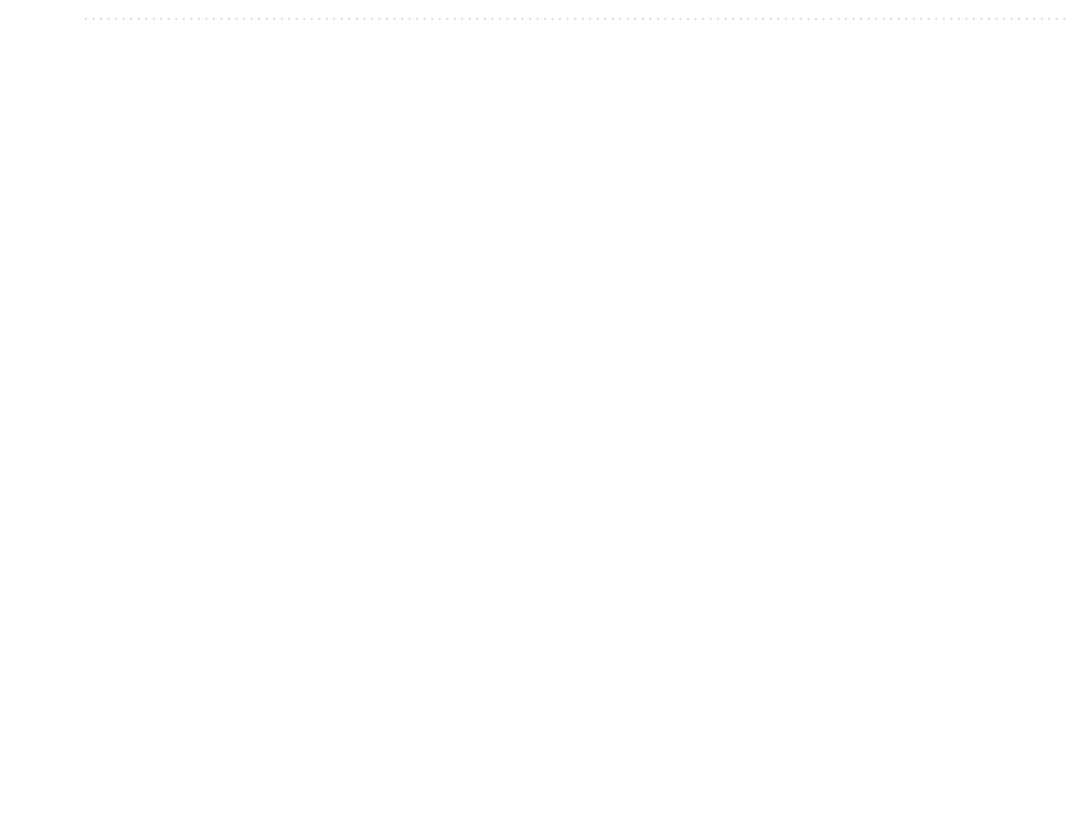
Table 8. HMH stresses and optimum topologies according to various load